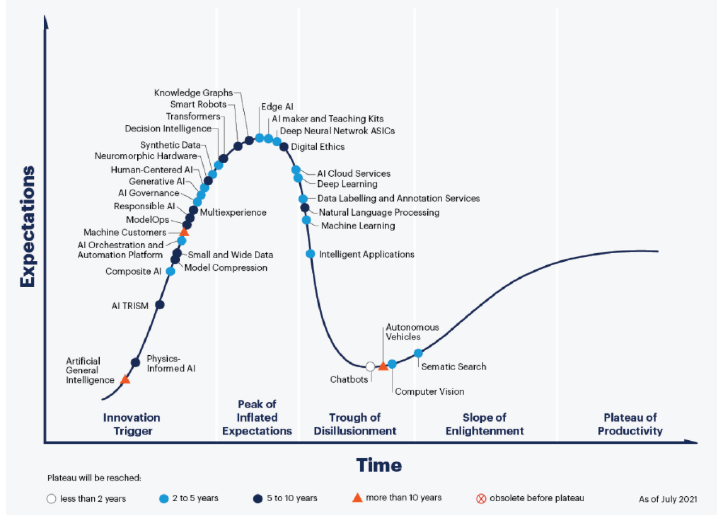
Figure 1. Gartner hype